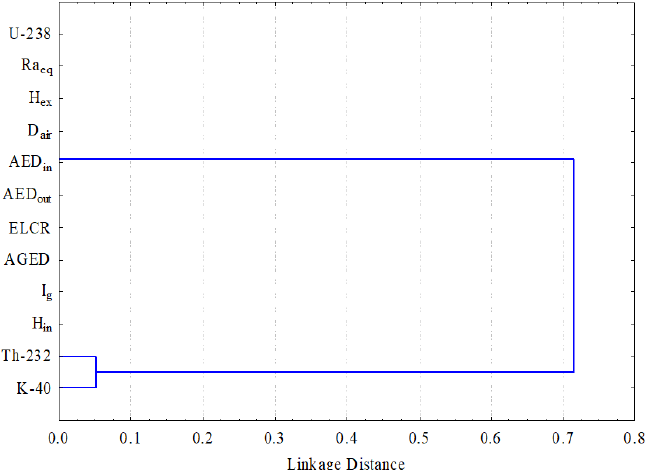
Figure 12. The clustering analysis of the radiological parameters of GR in the Sol Hamed area.